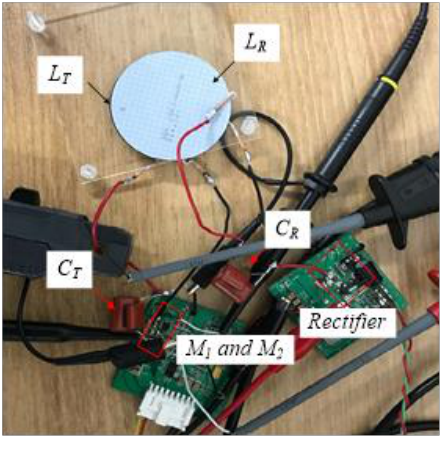
Table 1. Specific Components of the prototype.